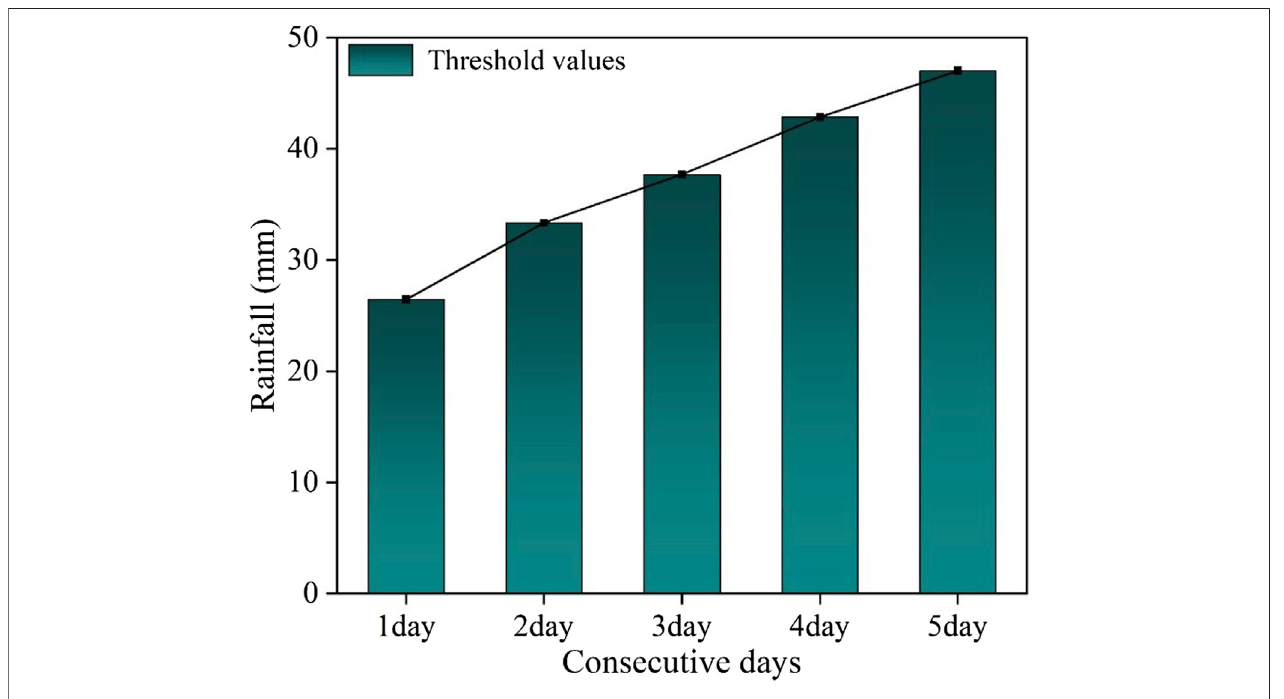
FIGURE 3 | 95th percentile threshold of extreme rainfall events with different